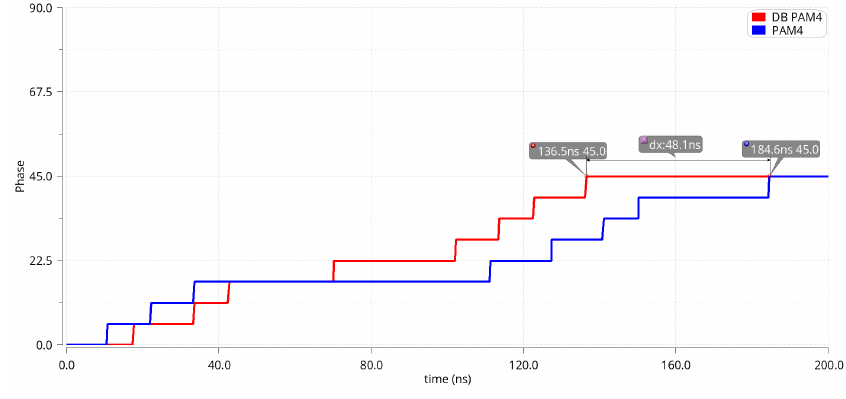
Figure 16. PI output phase in DB PAM-4 and PAM-4.